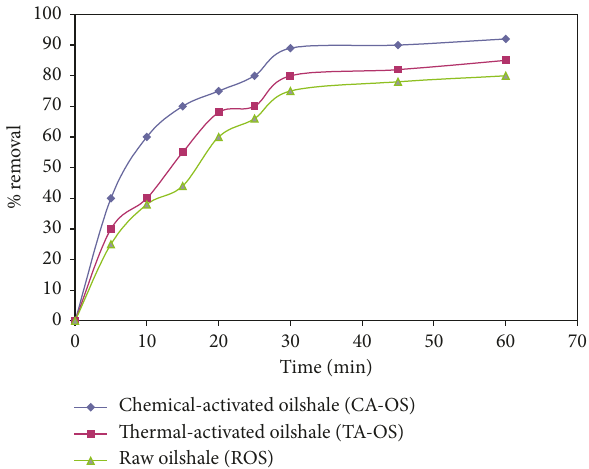
Figure 5: Comparison in the effect of adsorbent weight on the percentage removal of